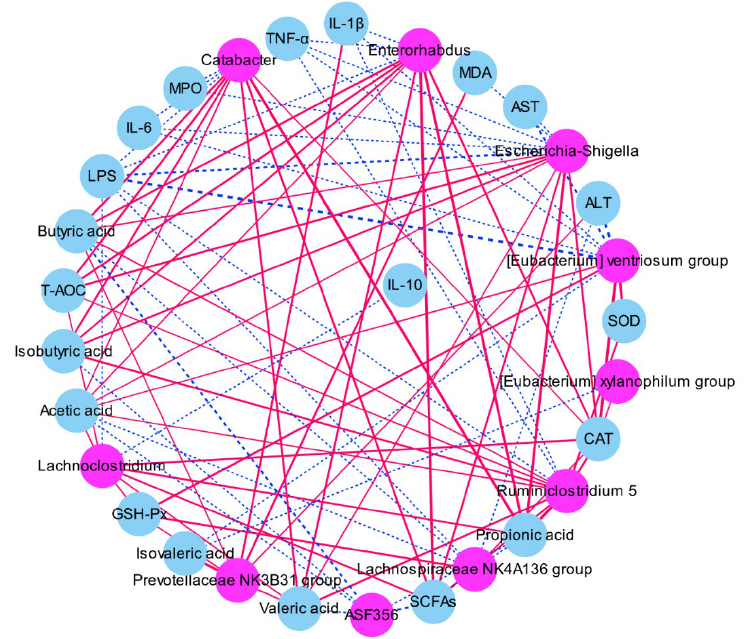
Figure 6. Correlation network of spearman’s correlations analysis between the key intestinal bacterial phylotypes and parameters of ALI. Red shows positive association, and blue shows negative association.